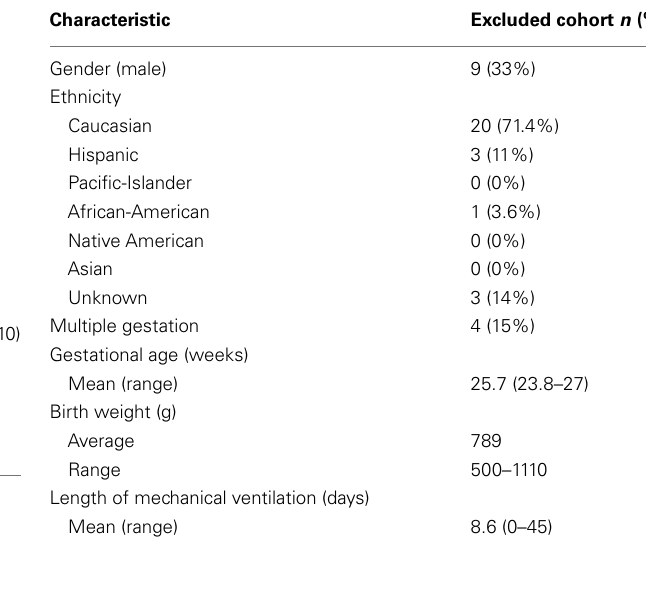
Table 2 | Selected demographic, birth, laboratory, and outcome characteristics of the excluded patients n = 27 (no magnesium levels drawn)